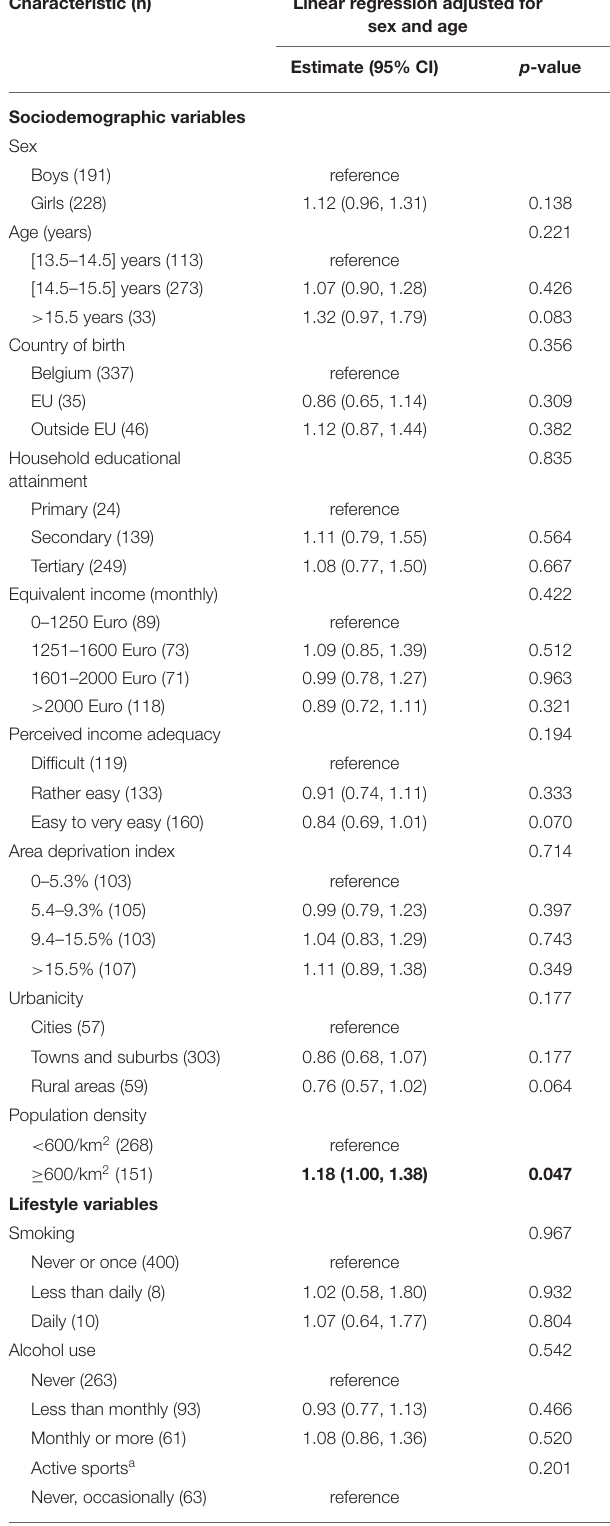
TABLE 3 | Linear regression analyses, adjusted for sex and age, for the assessment of determinants of hair cortisol concentrations in adolescents. Characteristic